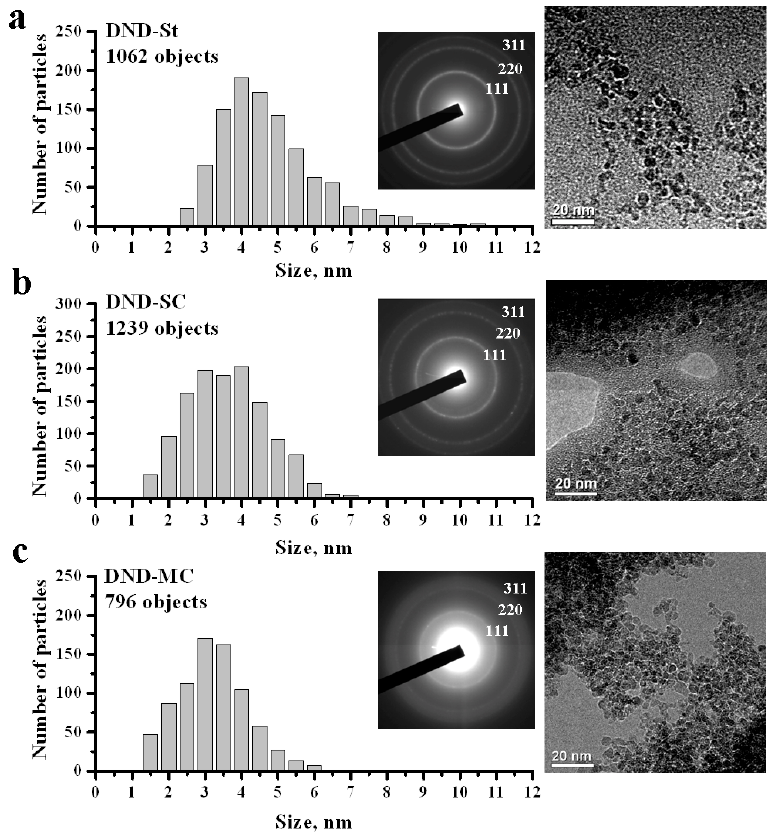
Figure 1. Particle size distributions for DND-St ( a ), DND-SC ( b ), and DND-MC ( c ) samples obtained using the TEM method, with their corresponding electron diffraction patterns and TEM images.